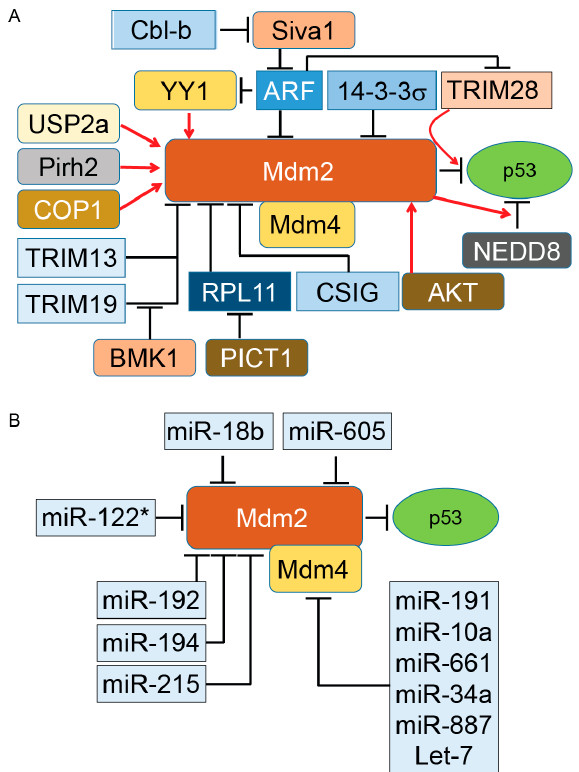
Figure 1. Regulation of murine double minute (Mdm)2 protein, a key E3 ubiquitin ligase of p53 tumor suppressor protein. By binding to p53, Mdm2 promotes ubiquitination of p53. The presence of Mdm4 and its binding to Mdm2 enhances ubiquitination and proteasomal degradation of p53. Basic research and clinical data indicate the important oncogenic role of both Mdm2 and Mdm4 in diverse types of